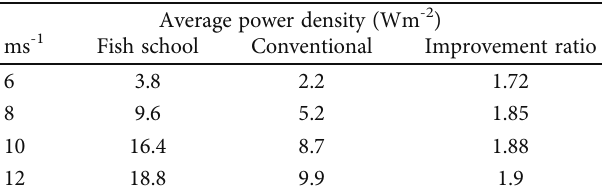
Figure 8: Wind farm power density Wm -2 as a function of direction and wind speed. Table 4: Average power density from all directions.